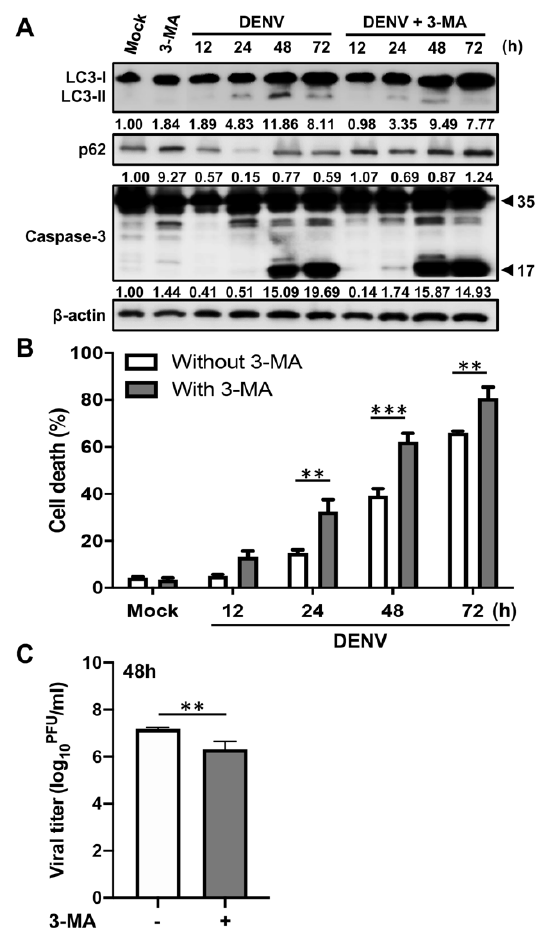
Figure 1. Inhibition of autophagy enhances DENV-induced apoptosis. A549 cells were pretreated with or without 5 mM 3-Methyladenine (3-MA) and then infected with DENV at the multiplicity of infection (MOI) = 2 for the indicated time. ( A ) Western blot analysis showing representative images of LC3-II accumulation, p62 degradation as well as procaspase-3 (35 kDa) and cleaved caspase-3 (17 kDa) levels in A549 cells. β -actin is shown for loading control. The blots were quantified by using β -actin as a calibrated control. The relative ratios (numbers below the blots) of LC3-II, p62 or cleaved caspase-3 to mock were indicated. ( B ) The percentage of cell death was determined by propidium iodide staining. Results shown are means ± SD for triplicate cultures. Statistical significance was based on two-way ANOVA followed by Bonferroni’s multiple comparison test. ( C ) The viral titers were determined by plaque assay. Results shown are means ± SD for triplicate cultures. Statistical analysis was performed using a two-tailed Student t -test. All the data are representative of independent experiments. ** p < 0.01, and *** p < 0.001.